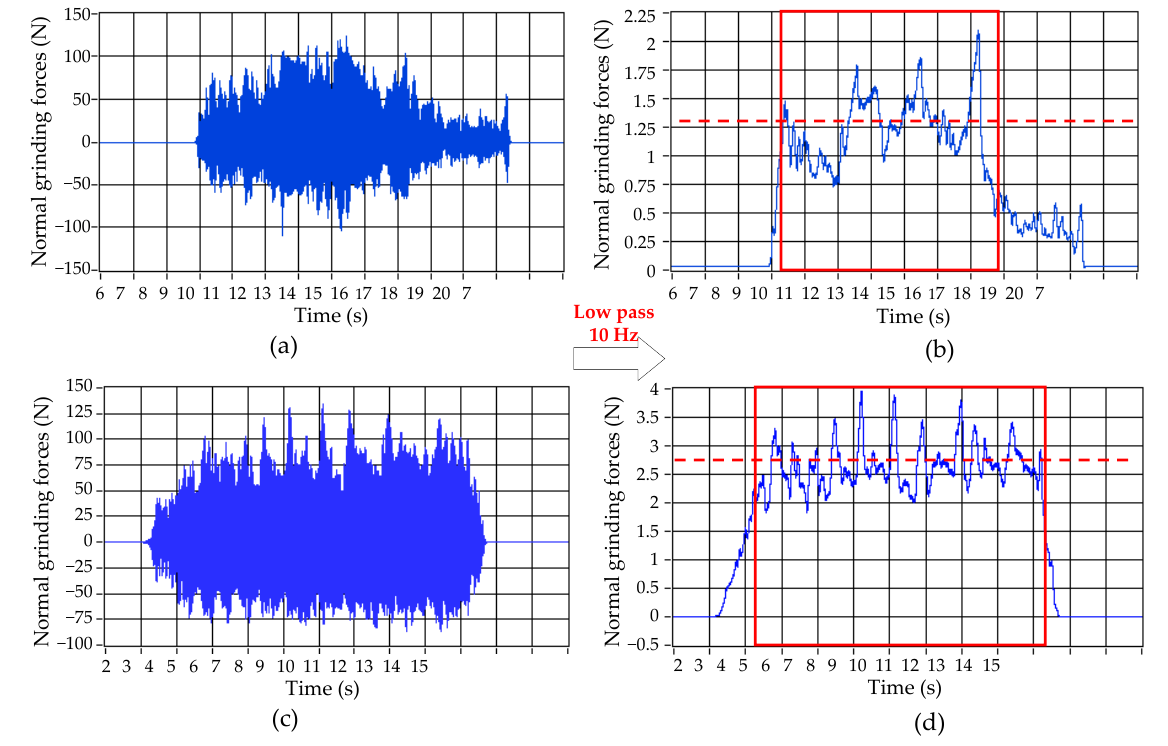
Figure 8. Normal grinding force ( k = 20 kHz, V = 1600 mm/min, S 1 = 80 µ m, N = 40). ( a ) Original signal (Layer: 0–15 µ m). ( b ) Filtered signal (Layer: 0–15 µ m). ( c ) Original signal (Layer: 75–90 µ m). ( d ) Filtered signal (Layer: 75–90 µ m).